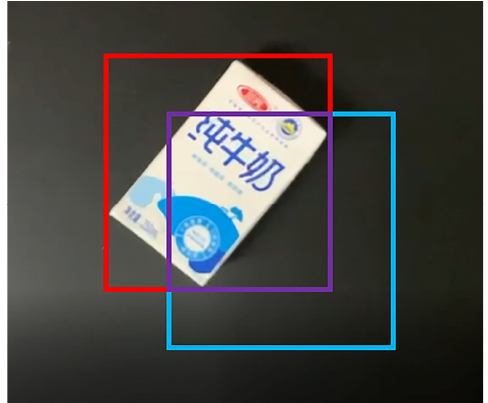
Figure 6. The schematic diagram of IoU .